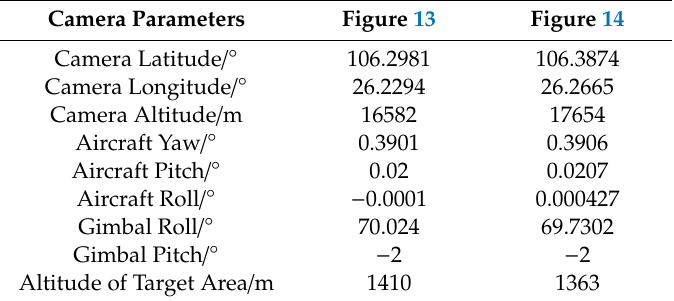
Table 2. Parameters of the camera and aircraft.